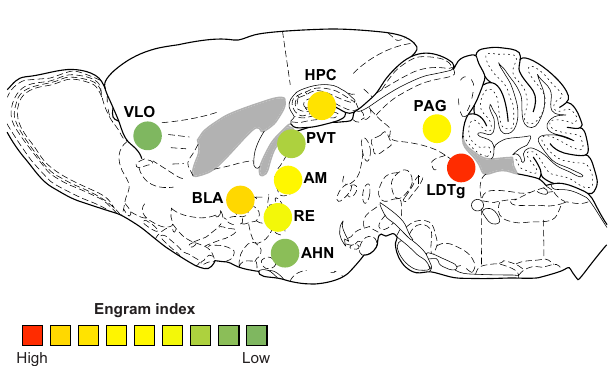
Fig. 7 A partial list of constituent engram ensembles in the uni fi ed engram complex for contextual fear conditioning memory. Distribution of the con fi rmed engram cells (from Fig. 4) in a sagittal mouse brain section, where the engram index values correspond to those in Fig. 2. Hippocampus